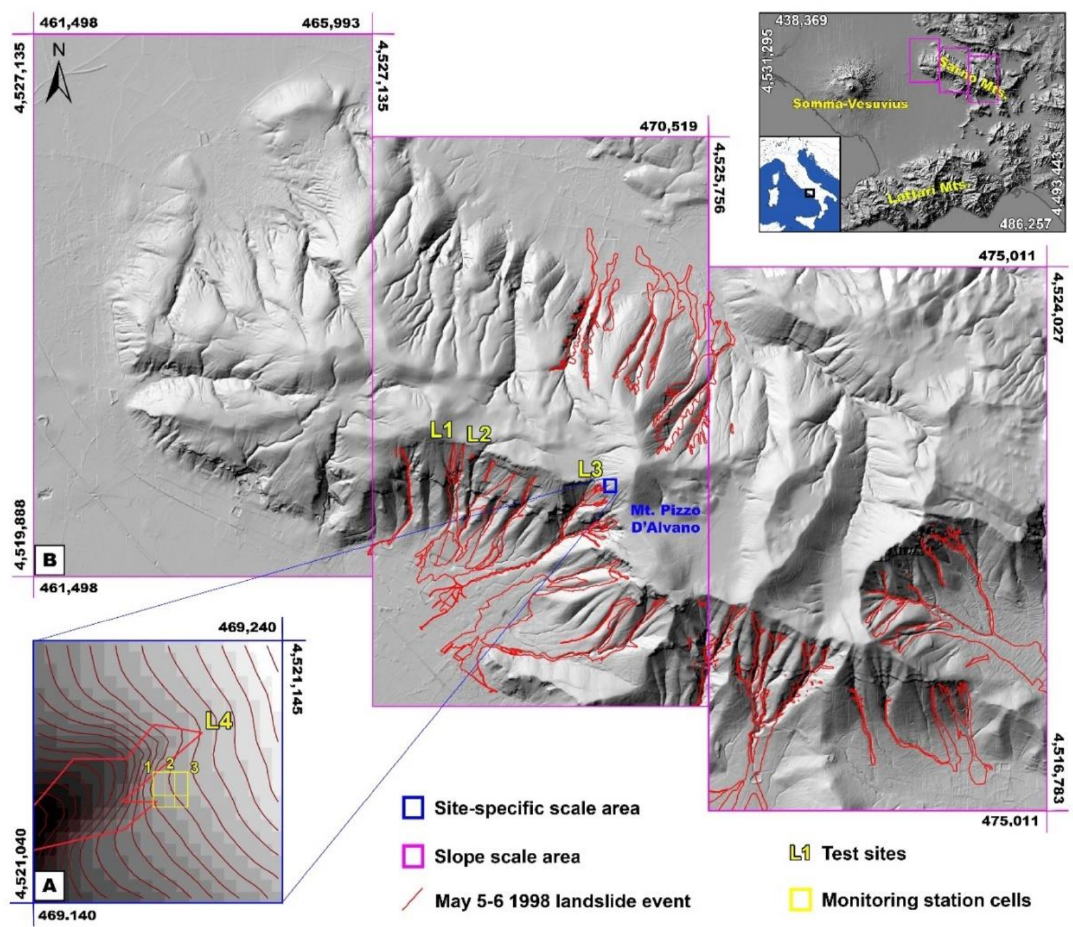
Figure 2. Sample areas considered for the Transient Rainfall Infiltration and Grid-Based Regional Slope-Stability (TRIGRS) analysis: ( A ) site-specific scale area, located on southwestern slope of Mt. Pizzo D’Alvano, in which the scarp of the initial slide area (cell 1) of one May 1998 landslide events (red contour) and location of the monitoring station (L4 test site; cells 2 and 3) are shown; ( B ) slope scale area coinciding with Sarno Mountains ridge and where the other three studied sample areas (L1, L2 and L3), corresponding to source areas of initial landslides occurred in May 1998, are shown (WGS84/UTM